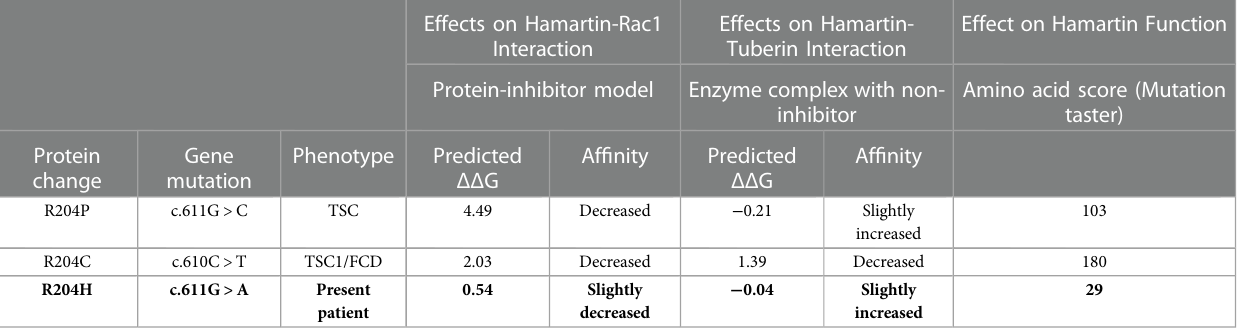
TABLE 2 In silico prediction of the effects of protein changes at position 204 of hamartin. The fi rst model evaluates the af fi nity of the mutated hamartin (inhibitor) to RAC1 (protein); the second reports on the effects on the interactions of hamartin and tuberin; the third model is taken from mutationtaster and evaluates the effects of the substitution of the new amino acid in comparison to the original protein (score 0 – 150) [see text for